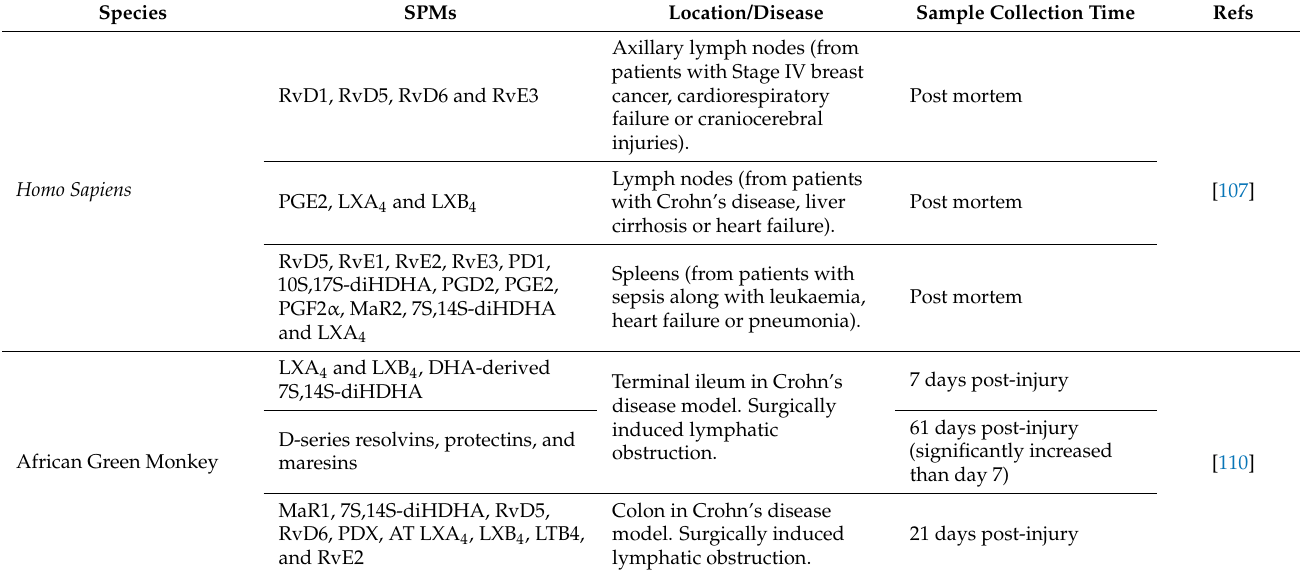
Table 2. In vivo detection of specialized pro-resolving mediators in lymphatic